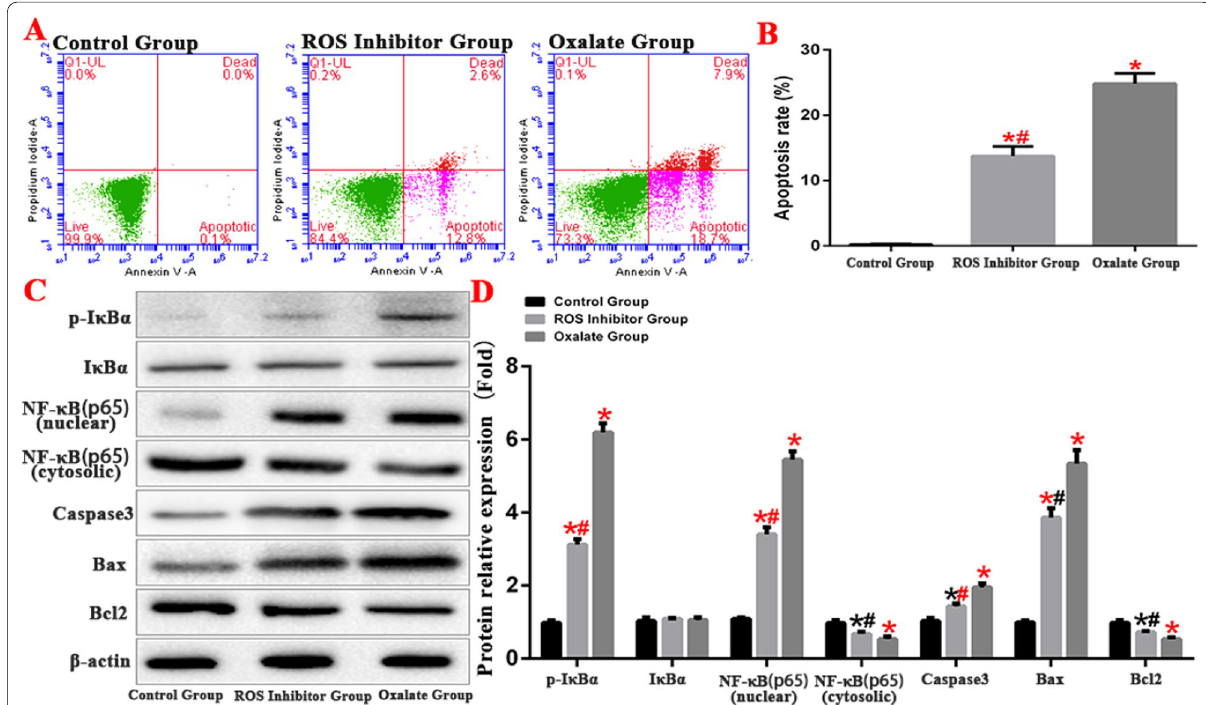
Fig. 11 ROS induces apoptosis of HK-2 cells by activating NF-κB signaling pathway. A , B Comparison of apoptosis detection in each group by flow cytometry. C , D Western blot was used to detect the expression of apoptosis-related proteins and NF-κB protein in each group. (*compared with normal Control group, P < 0.05.* (Red) Compared with Control group, P < 0.01. # Compared with oxalate group, P < 0.05. #(Red) Compared with oxalate group, P <